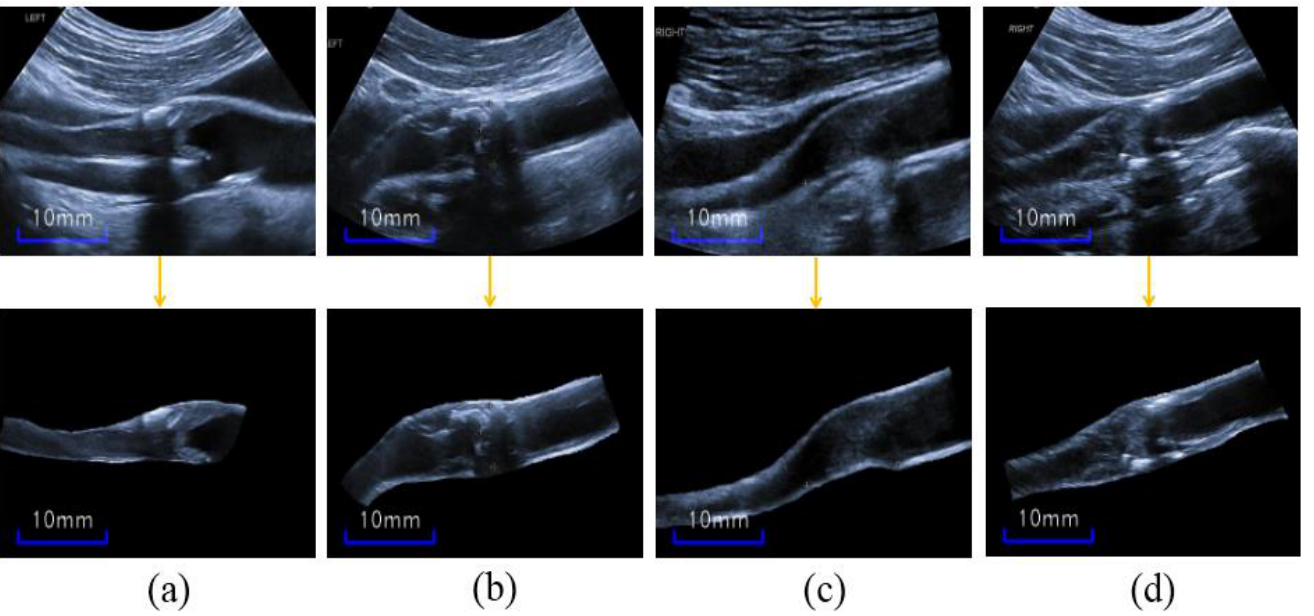
Figure 4. ( a – d ) Original ultrasound images (the first row) and the corresponding cropped-artery- blood-vessel images (the second row).